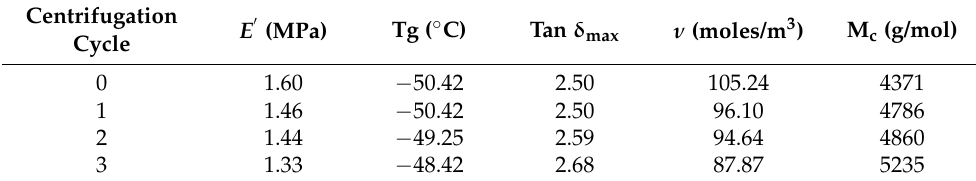
Figure 8. Storage module (E ΄ ) as a function temperature for DPNRs with different counts of centrifugation cycles. Table 1. Values of E ΄ , T g , Tan δ max , ν , and M c of DPNRs.